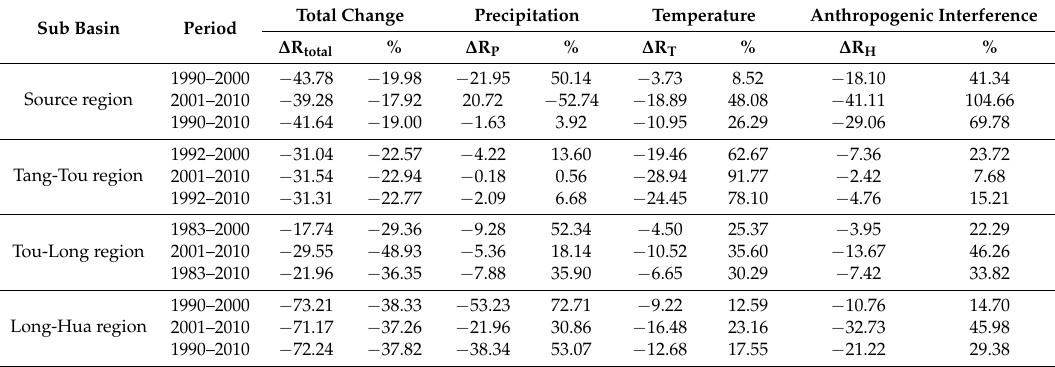
Table 5. Contribution of precipitation, temperature, and anthropogenic interference on annual streamflow variation in four regions of the YRB.